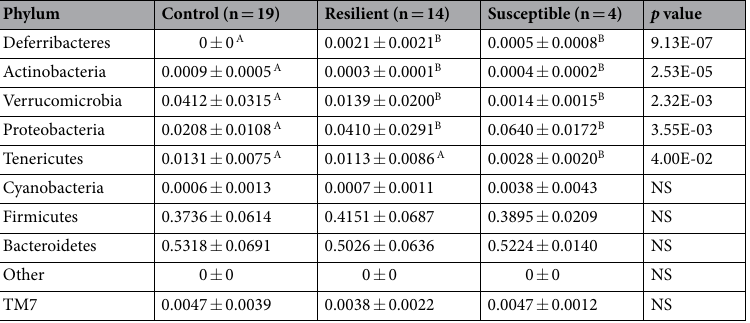
Table 2. Relative abundances of bacterial phyla in control vs . resilient vs . susceptible mice exposed to chronic mild social defeat stress. All values are presented as mean ± standard deviation. The phyla are listed in order of significance (Kruskal-Wallis test). Means not sharing the same superscript are significantly different at p <